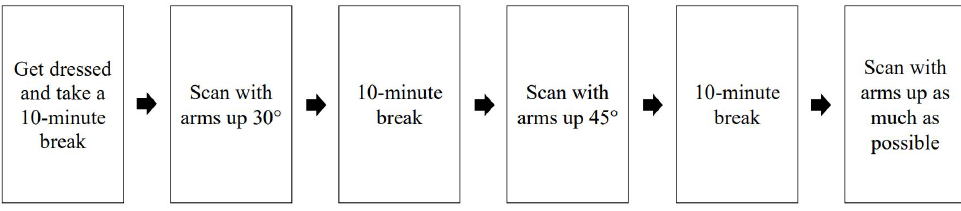
Figure 3. Process of